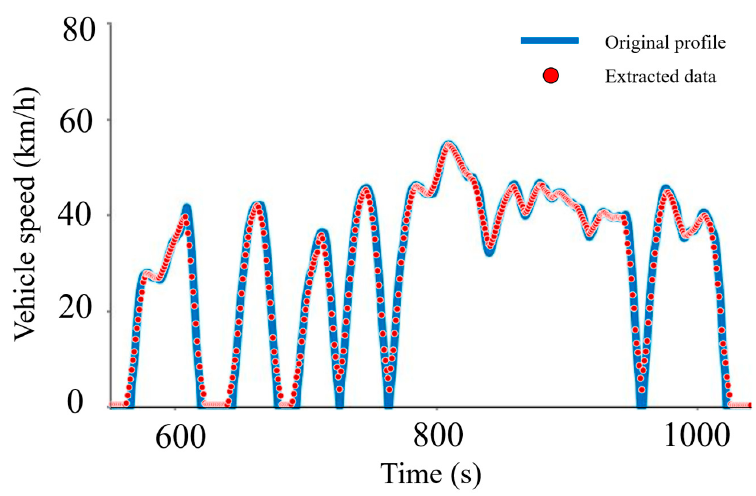
Figure 1. Example of data extraction in WebPlotDigitizer for a time section in FTP-75 cycle.